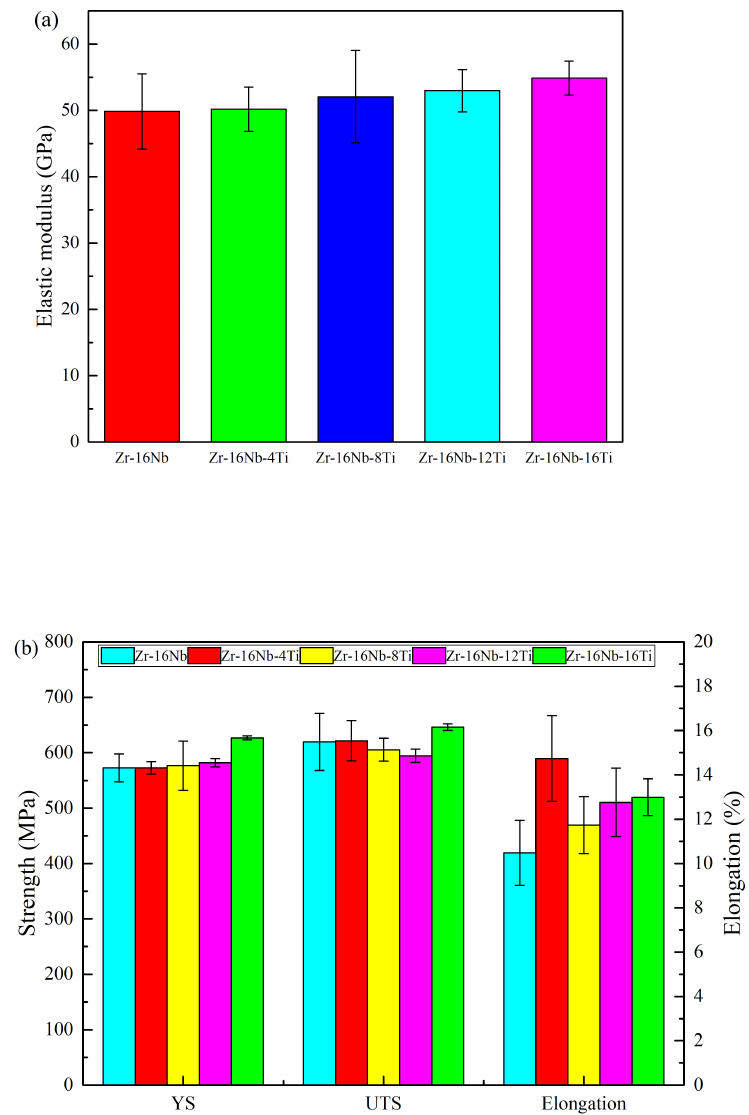
Figure 5. Mechanical properties of the Zr-16Nb-xTi alloys: ( a ) Young’s modulus; ( b ) Strength and Elongation.